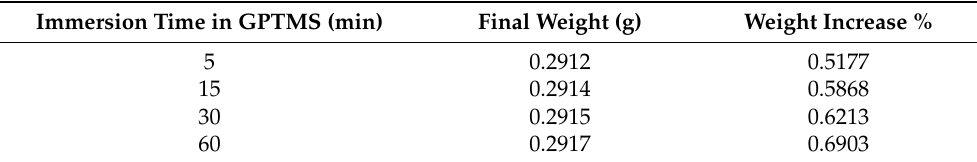
Table 4. Weight increase of aluminum specimens after immersion in hydrolyzed 3% GPTMS at pH 5 and 25 ◦ C.